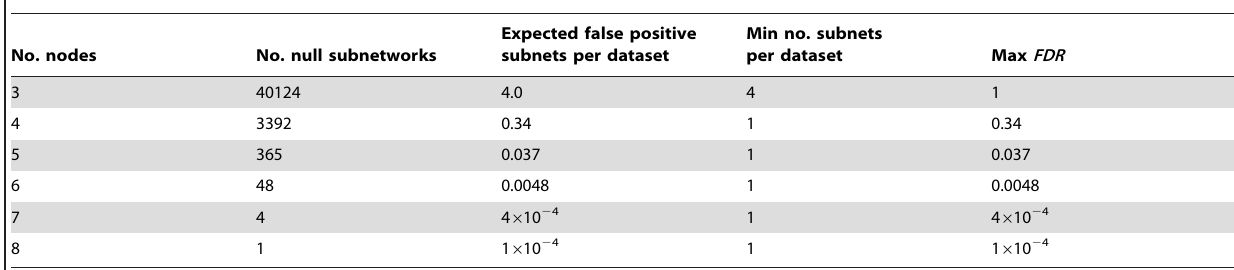
Table 4. Null subnetwork analysis.